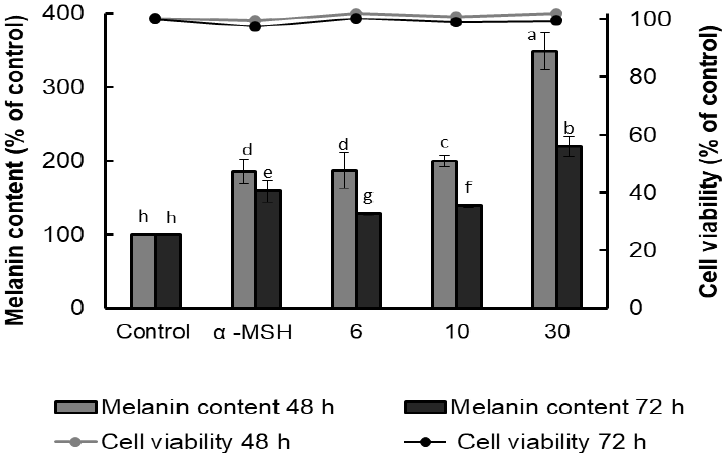
Figure 2. Effect of argan fruit shell ethanol extract (AFSEE) on the melanin content (bar graph) and cell viability (line graph) of B16F10 cells cultured in a 100 mm dish at a density of 5×10 5 cells/dish, and treated without (control) or with α-MSH (200 mM) or AFSEE (6, 10, and 30 µg/mL) for 48 or 72 h. Each bar represents the percentage of viable cells versus control, expressed as mean ± SD of four independent experiments, each one performed in triplicate. Data were subjected to ANOVA ( n = 3). All comparisons were made between treatments. Different letters indicate treatment differences at p ≤ 0.05 level.